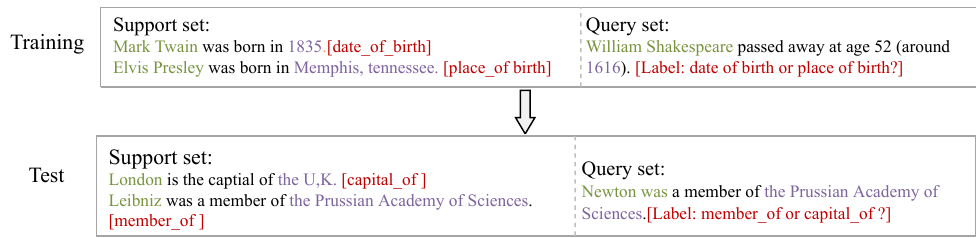
Figure 1. A 2-way 1-shot meta task for few-shot relation, where the head entity, the tail entity and the relation category are in green, purple and red, respectively. The relation categories in training and test stage are